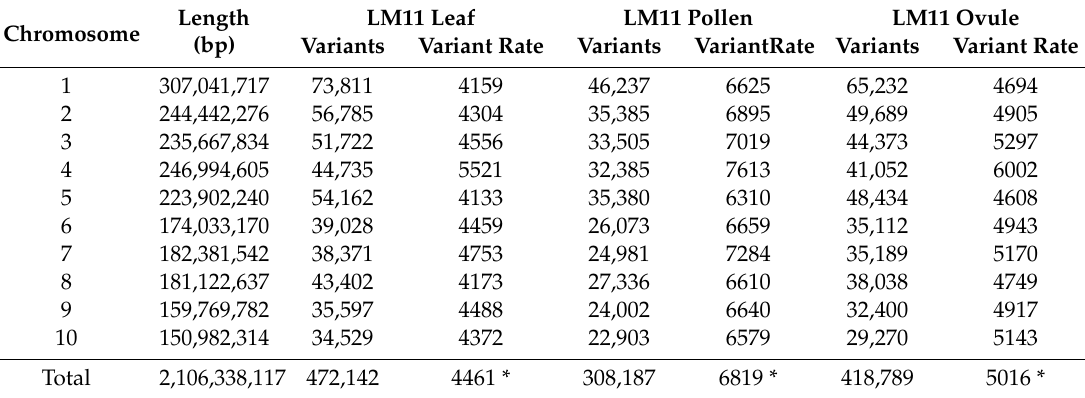
Table 2. Chromosome-wise distribution of variants in